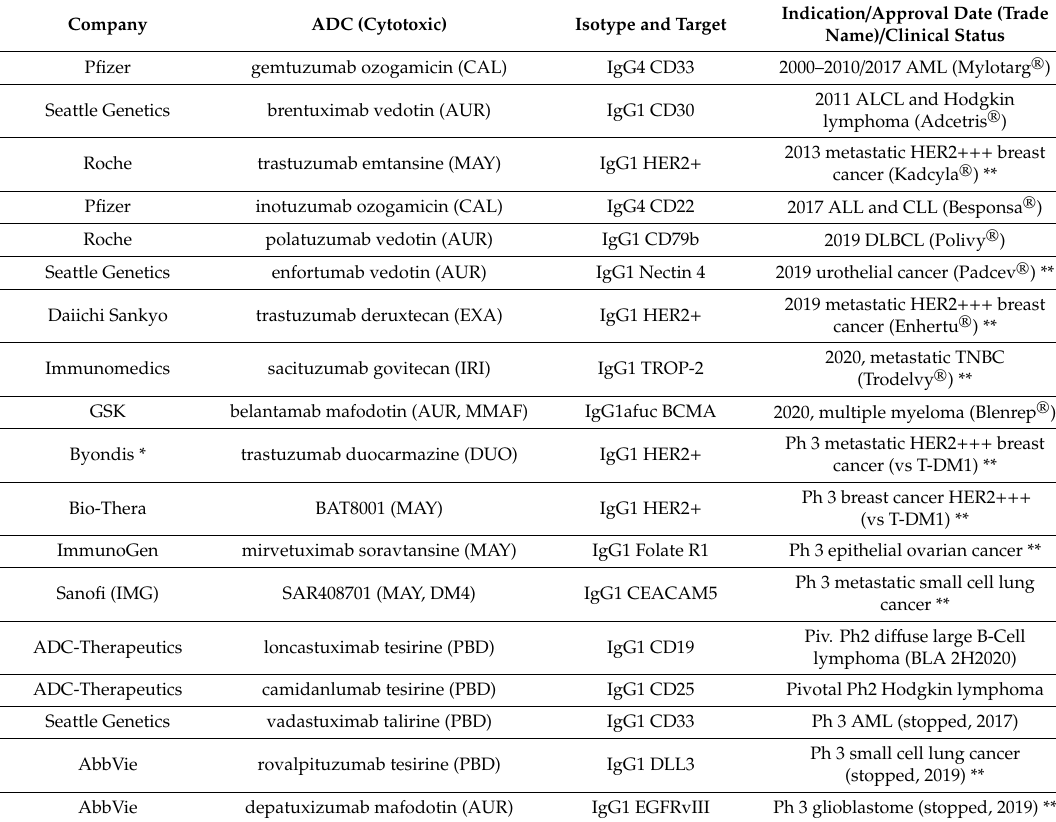
Table 1. Antibody–drug conjugates (ADCs) approved by the Food and Drug Administration (FDA), in advanced clinical trials (Phase III or pivotal phase II) or recently